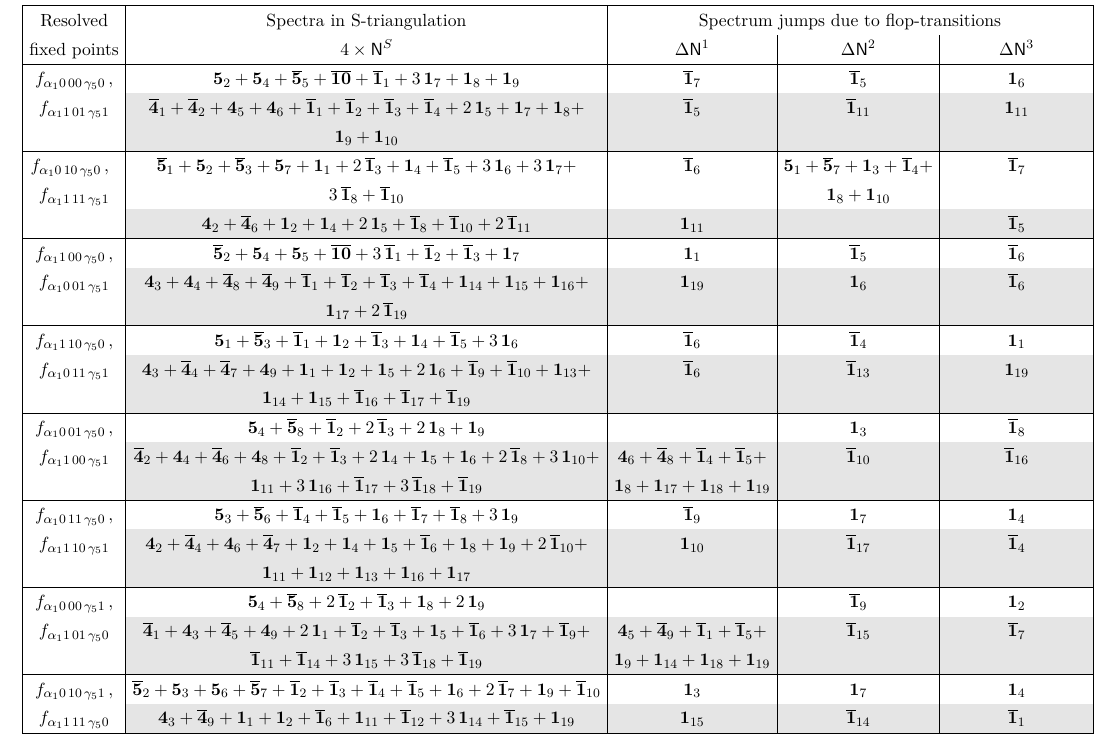
Table 10 . Each big row corresponds to two sets of four resolved C 3 / Z 2 × Z 2 fixed points labelled by α 1 , γ 5 = 0 , 1 (because their local bundle vectors are identical and thus so are their local spectra). The lines with the white background give the observable spectra resulting from the first E 8 and the lines with grey background the hidden spectrum from the second E 8 . The charge states are labeled in table 9. (Since all singlet are charged it make sense to talk about a singlet state or its conjugate.) The second column gives the contributions at the four local resolved singularities using the S-triangulation combined. The columns ∆ N 1 , ∆ N 2 and ∆ N 3 indicate the jumps in the spectra for a single resolved fixed point out of these sets of four